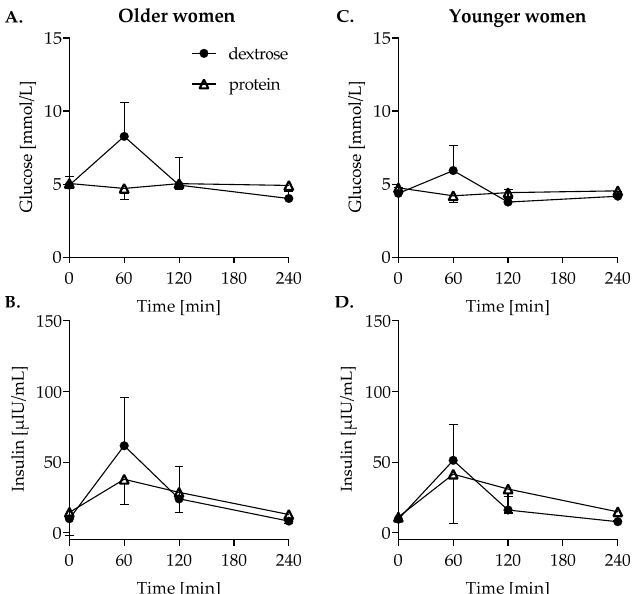
Figure 3. Postprandial glucose ( A ) and insulin ( B ) concentrations in older and younger women (( C , D ) respectively) following dextrose (closed circles) and high protein (open triangles ingestion. Repeated measures ANOVA, data are shown as mean ± SD. n = 10 per group; n = 9 in the younger high-protein group. Closed circles represent older women, open rectangles younger women.